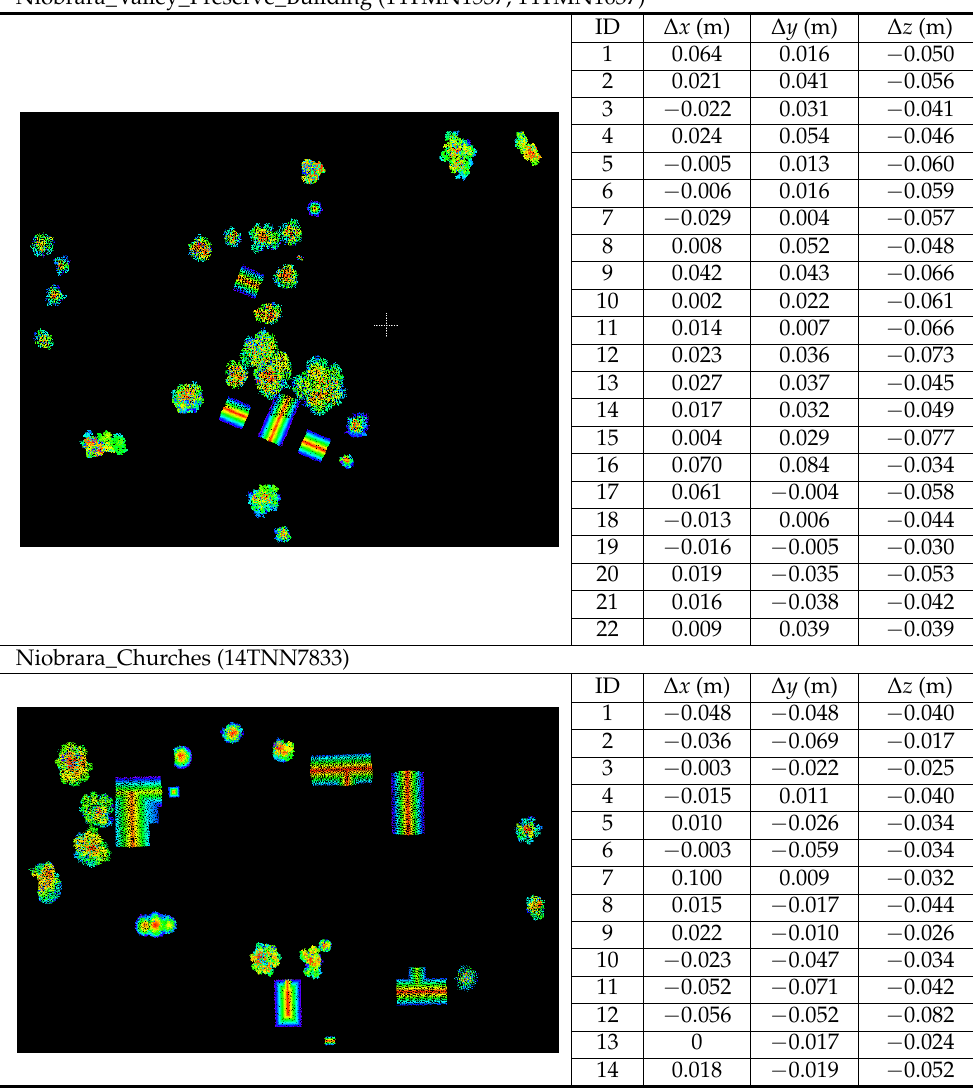
Table 2 lists the result of positional differences between the reference point cloud and the airborne data point cloud using the amorphous method, where each result is the result from 50 iterations. Each site ID represents an extracted area of the TLS point cloud data, and the corresponding airborne lidar point cloud tile name is within the parentheses in Table 2. Using all differences from 108 trees, the final accuracy results of the airborne point cloud are computed as shown in Table 3. Additionally, shown are the horizontal and vertical error distributions in Figure 8. The final uncertainty of the data around 3–4 cm horizontal and 2 cm vertical is an excellent result compared to typical airborne lidar accuracy. Note that USGS QL1 requirement is 10 cm. While the mean vertical error 4.5 cm is not negligibly small, the mean horizontal error is near zero, which is ideal. Table 2. Three-dimensional positional differences using the amorphous object method (TLS— airborne data).